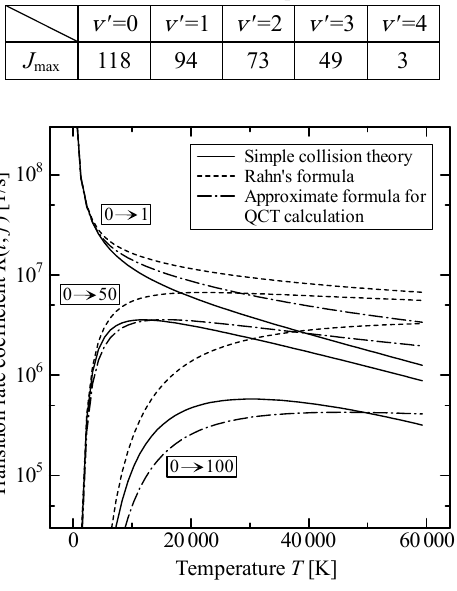
Fig. 3 Temperature dependence of transition rate coefficient for each